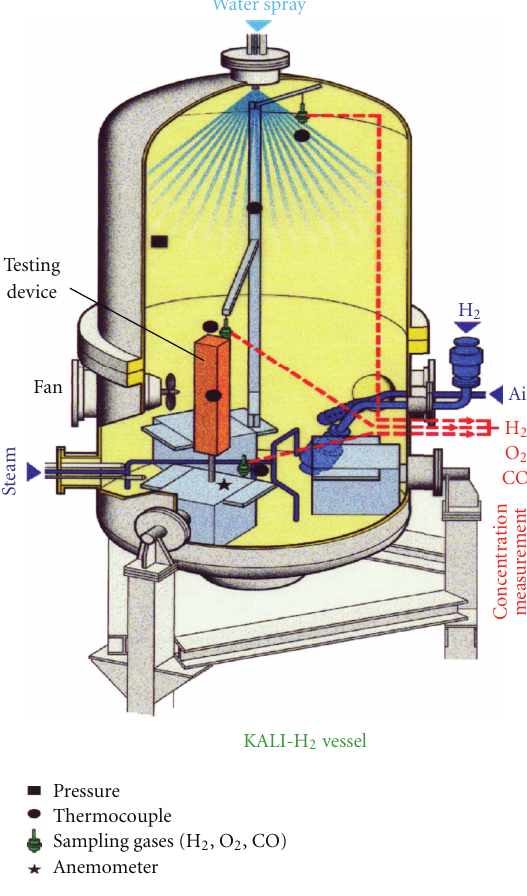
Figure 6: KALI-H 2